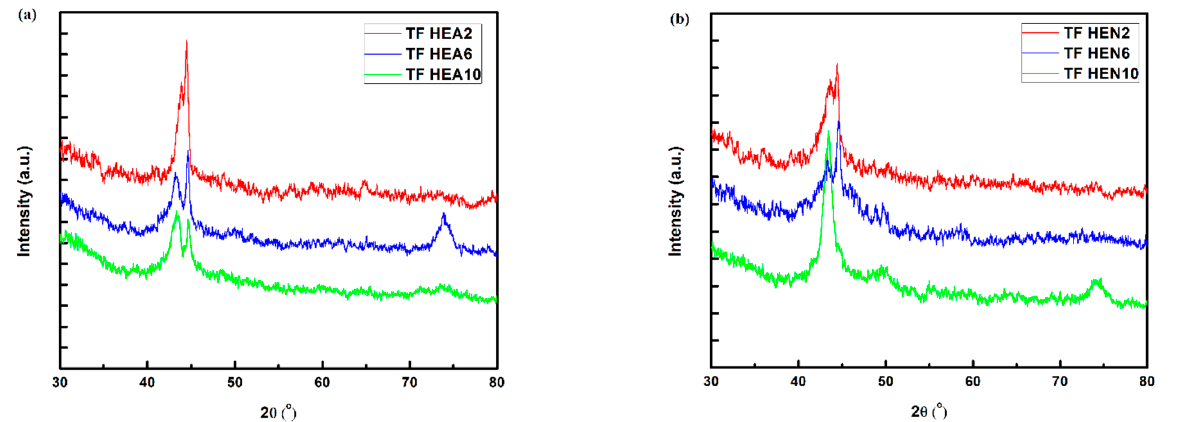
Figure 2. XRD patterns of ( a ) the analysed thin HEA films and ( b ) the analysed thin HEN films, both containing different nickel molar content, 0.4, 1.2, and 2.0. TF stands for thin film.